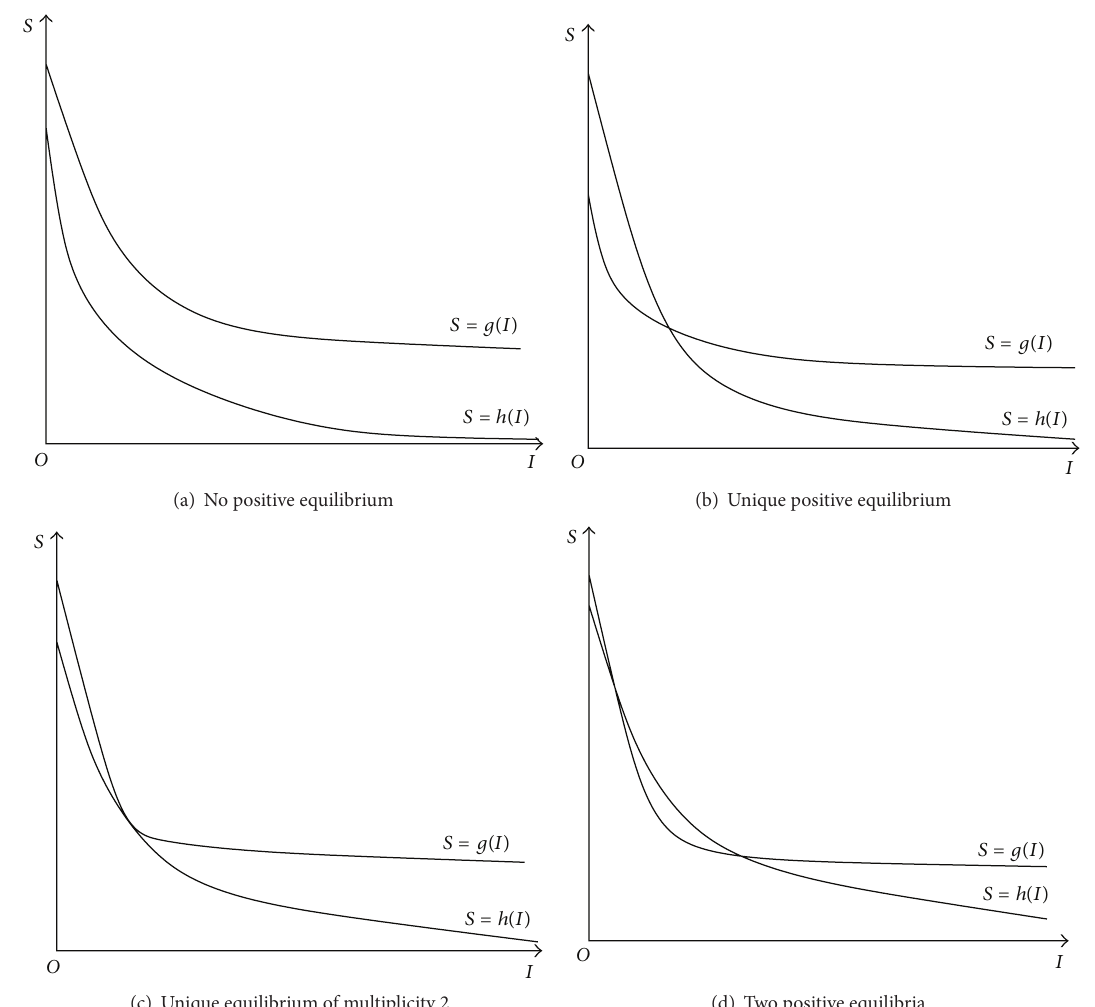
Figure 1: Existence and number of endemic